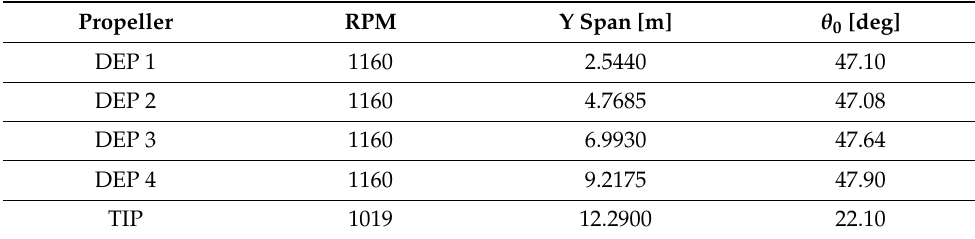
Table 5. Mot. 2: Propellers’ RPM and collective pitch in 40%-ETR